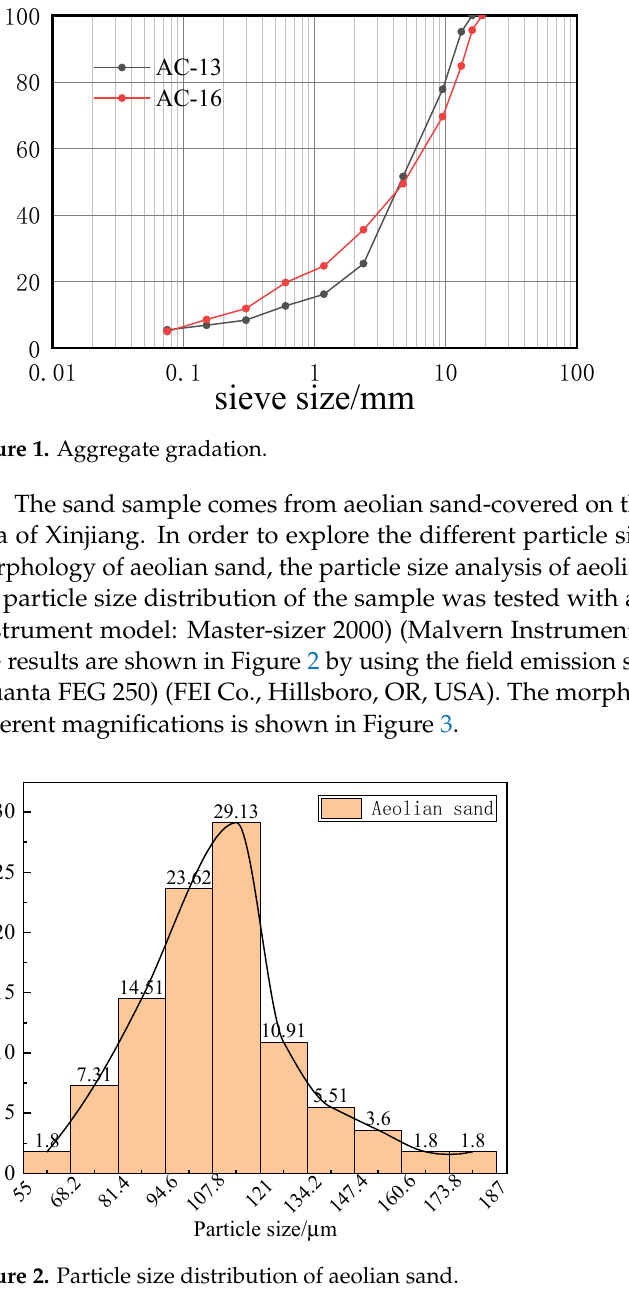
Figure 2. Particle size distribution of aeolian sand.